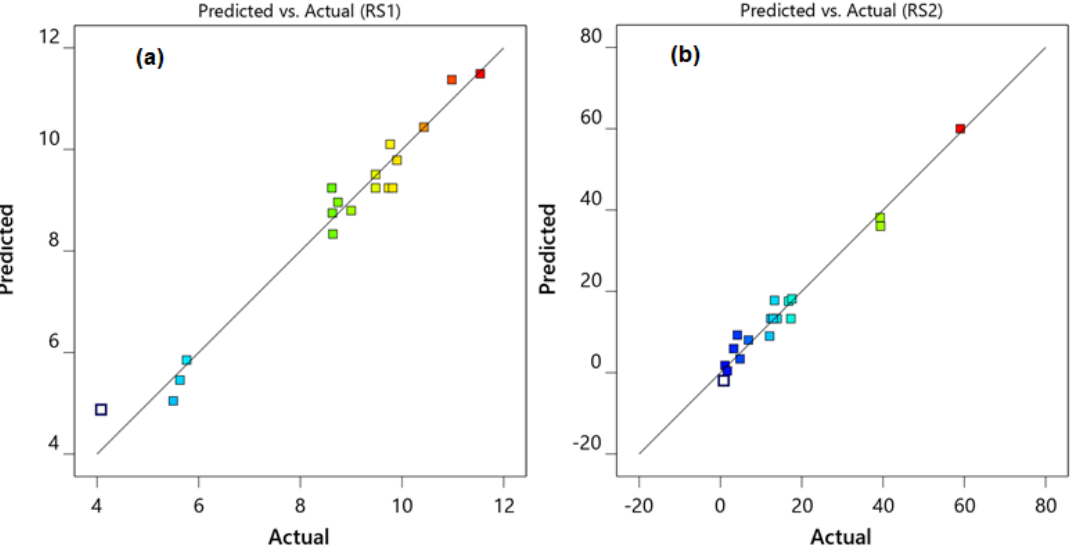
Figure 4. Diagnostic plots for resolutions of RE − VD ( a ) and VD − MF ( b ) showing the comparison of actuals, against predicted resolution values.